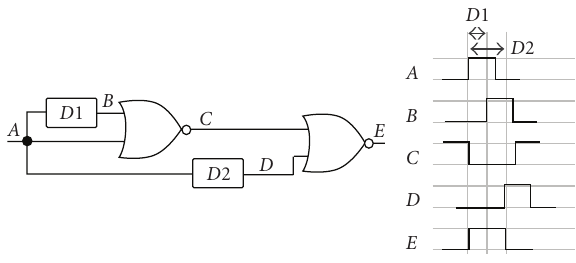
Figure 7: A design for the pulse regenerator